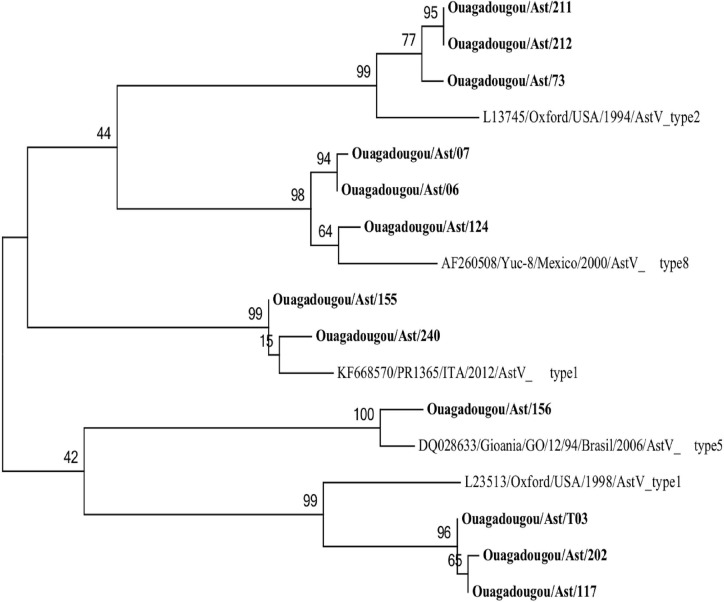
Phylogenetic analysis based on the partial nucleotide sequences (373 bp) of an area located in the open-reading frame (ORF2) of Astrovirus detected in Ouagadougou, Burkina Faso, between November 2011 and September 2012.The tree was constructed using Maximum Likelihood method. Reference strains of astrovirus were selected from the GenBank database.